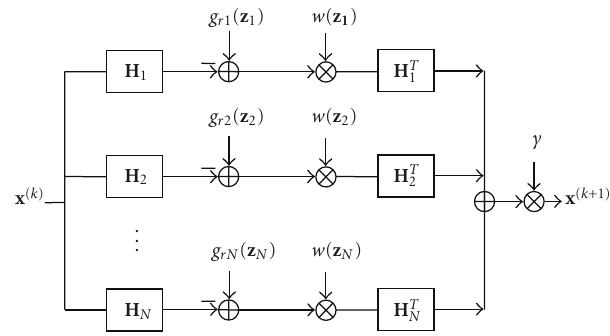
Figure 4: Spatial resolution enhancement framework using IMF. g ri ( · ) is the IMF that converts input image z i to the photometric range of reference image. H i applies spatial transformations, con- sisting of geometric warping, blurring, and downsampling. Sim- ilarly, H iT applies upsampling with zero insertion, blurring, and back-warping. γ is the step size of the update; it is computed at each